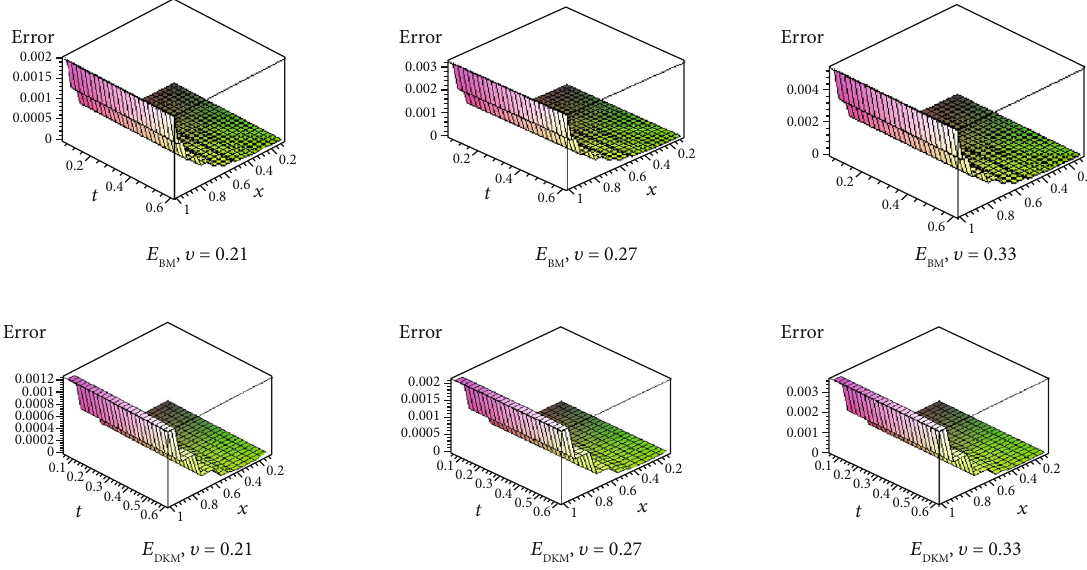
Figure 2: The values of errors by B-by-BM and DKM at T = 0 : 6 , N = 10 , and k = 1 for υ = 0 : 21, 0 : 27, 0 : 33